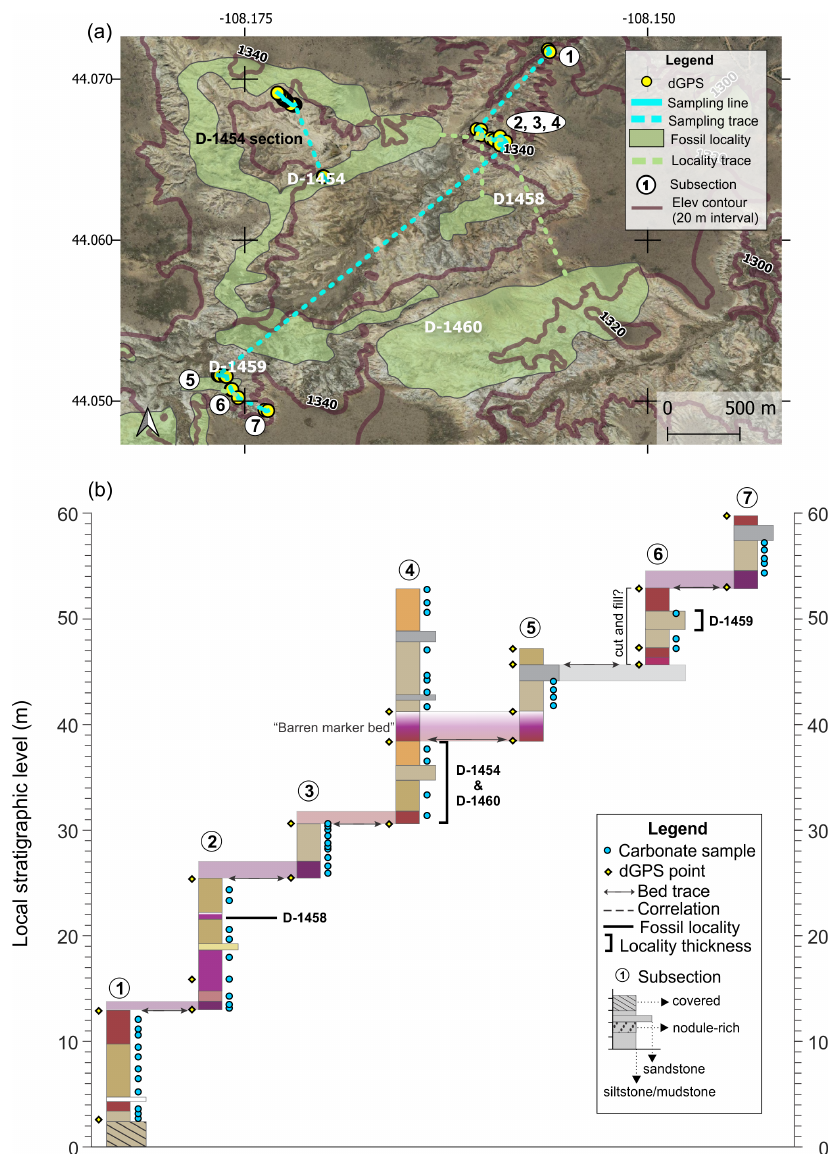
Figure A1. Basin Draw section (a) map and (b) diagram showing sampling subsections, dGPS tie points, bed traces, and correlated fossil localities. Colored boxes in (b) represent the surface color of weathered rocks. Marker beds used to trace between subsections are shown in light shading with arrows along the bed surface used for tracing. Basemap source: Google Earth © 2021. A high-resolution map is available in the supplemental data repository (Widlansky et al.,